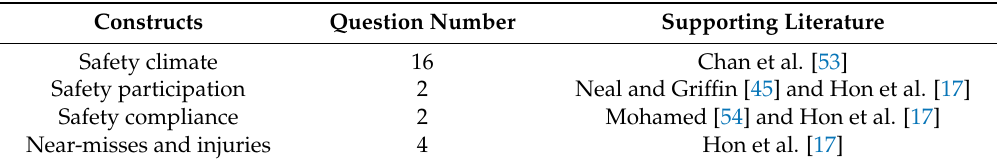
Table 1. Construct